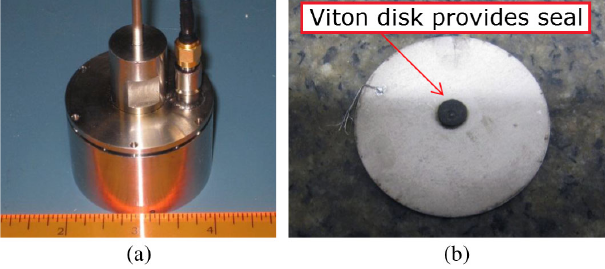
FIG. 4. (a) Piezoelectric valve case. (b) Piezoelectric valve shown with the Viton disk glued on